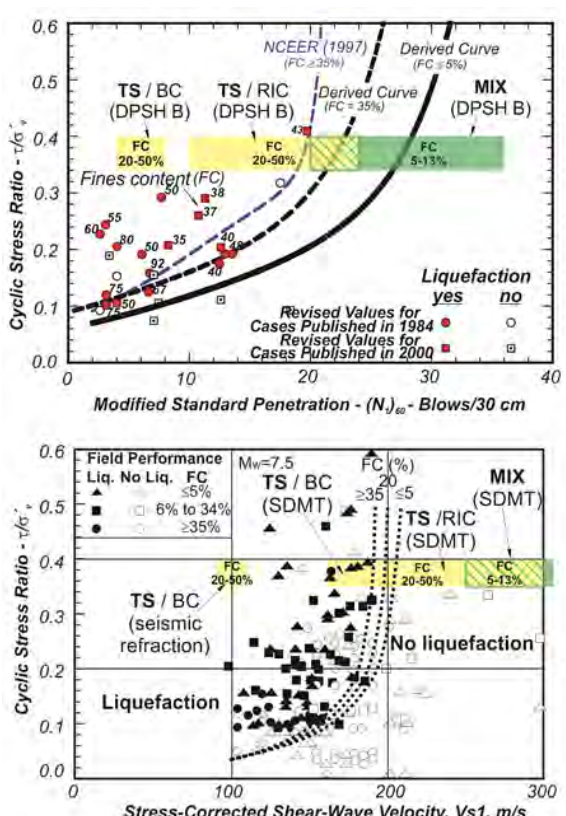
Figure 29. Diagrams for evaluation of liquefaction potential based on ( N 1) 60 (upper) and v s 1 (lower). BC – before compaction, FC – fines content, MIX – soil mixture, RIC – Rapid Impact Compaction, TS – top soil